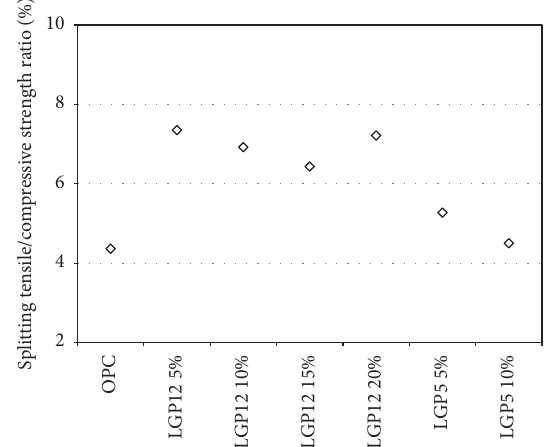
Figure 8: Relationship of splitting tensile by compressive strength ratio and LGP proportion.